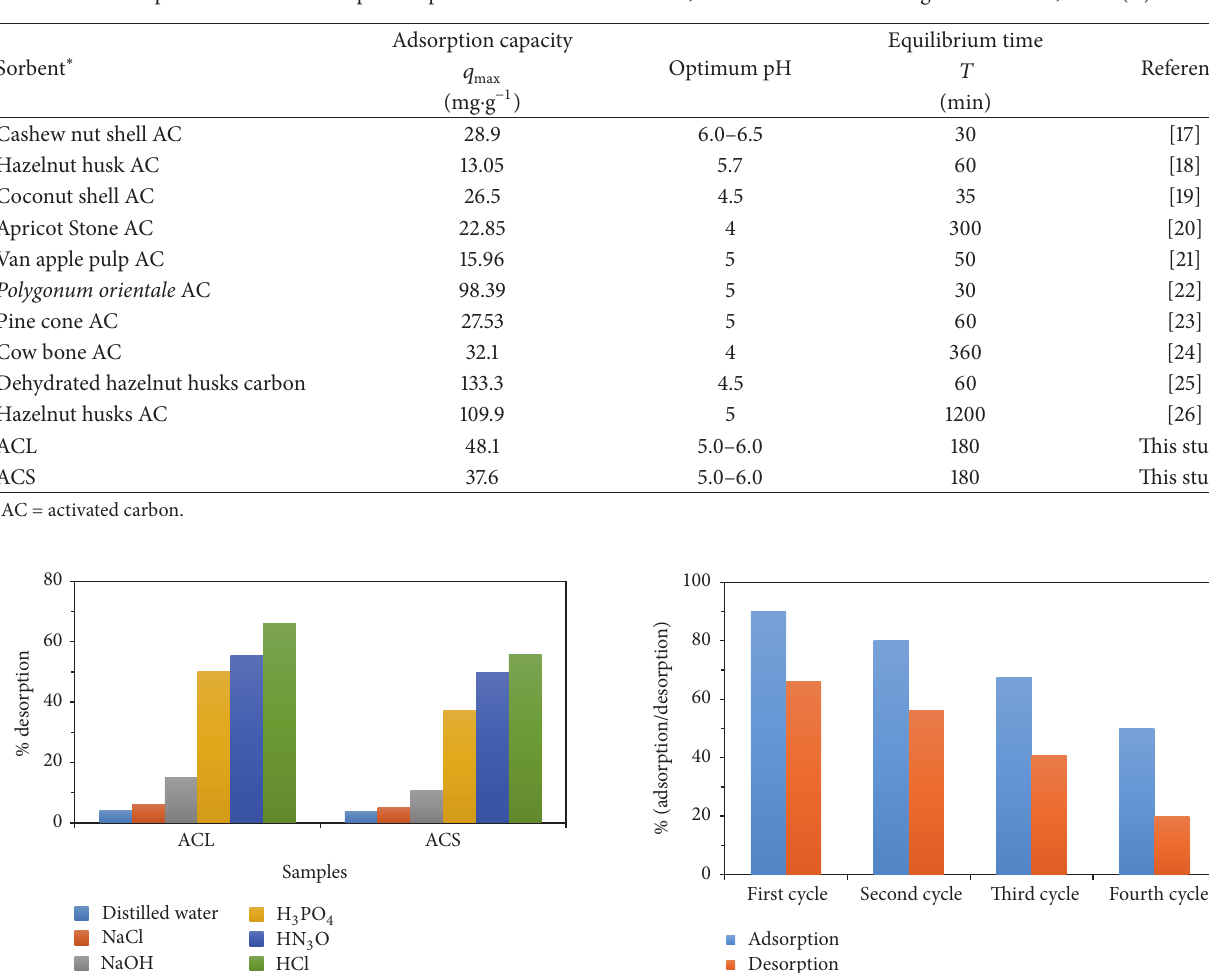
Table 4: Comparison between adsorption capacities of several adsorbents, obtained from natural organic materials, for Pb(II) ions.